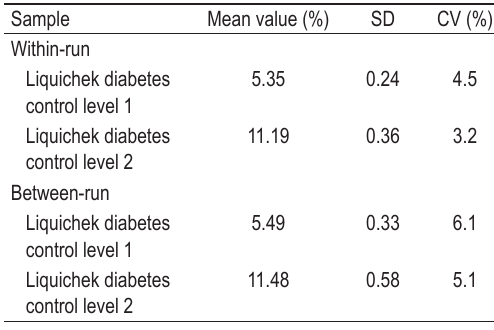
TABLE 2. Precision of HbA1c assay